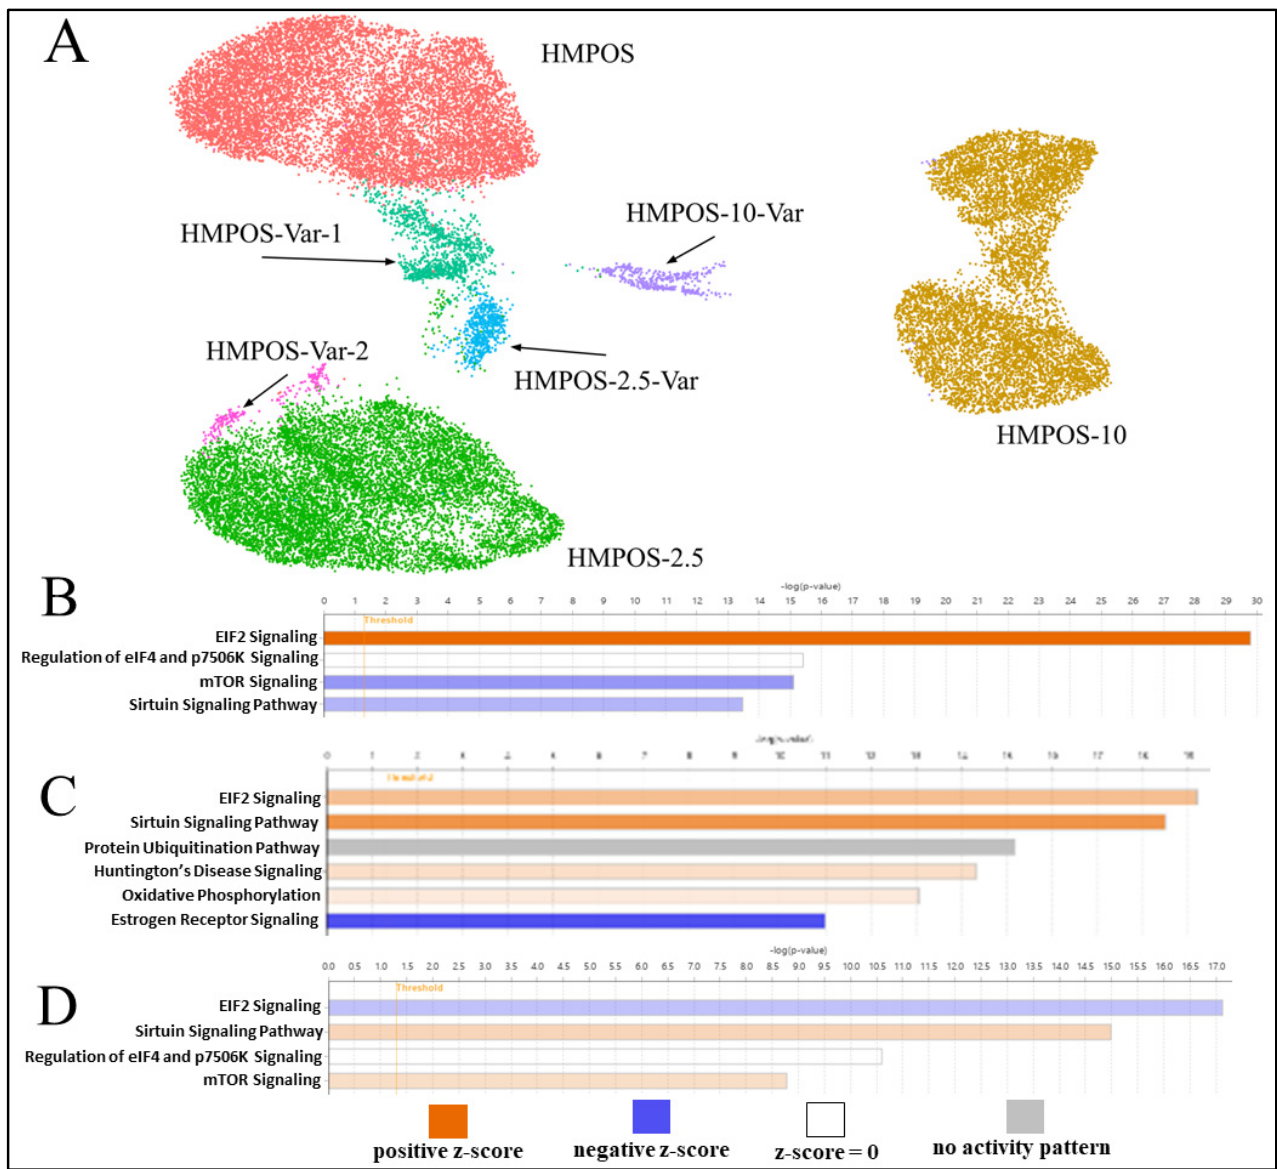
Figure 5. ( A ) UMAP plot of HMPOS, HMPOS-2.5, and HMPOS-10 and the subclonal populations that were distinct from the main cell lines. HMPOS-Var-1 and HMPOS-Var-2 are variants of HMPOS, though the low cell count of 249 cells of HMPOS-Var-2 led to its exclusion from further analysis. HMPOS-2.5-Var is a variant of HMPOS-2.5 and HMPOS-10-Var is a variant of HMPOS-10. ( B ) Pathway analysis comparing HMPOS and HMPOS-2.5, with positive z-scores in orange indicating pathway activation and blue indicating pathway inhibition in HMPOS-2.5 compared with HMPOS. The color’s intensity represents the z score’s distance from the mean, with darker color indicating greater distance. ( C ) IPA comparing HMPOS-10 with HMPOS and HMPOS-2.5. ( D ) IPA comparing HMPOS-10 cells in clusters 1 and 5, which can be seen in Figure 3B.